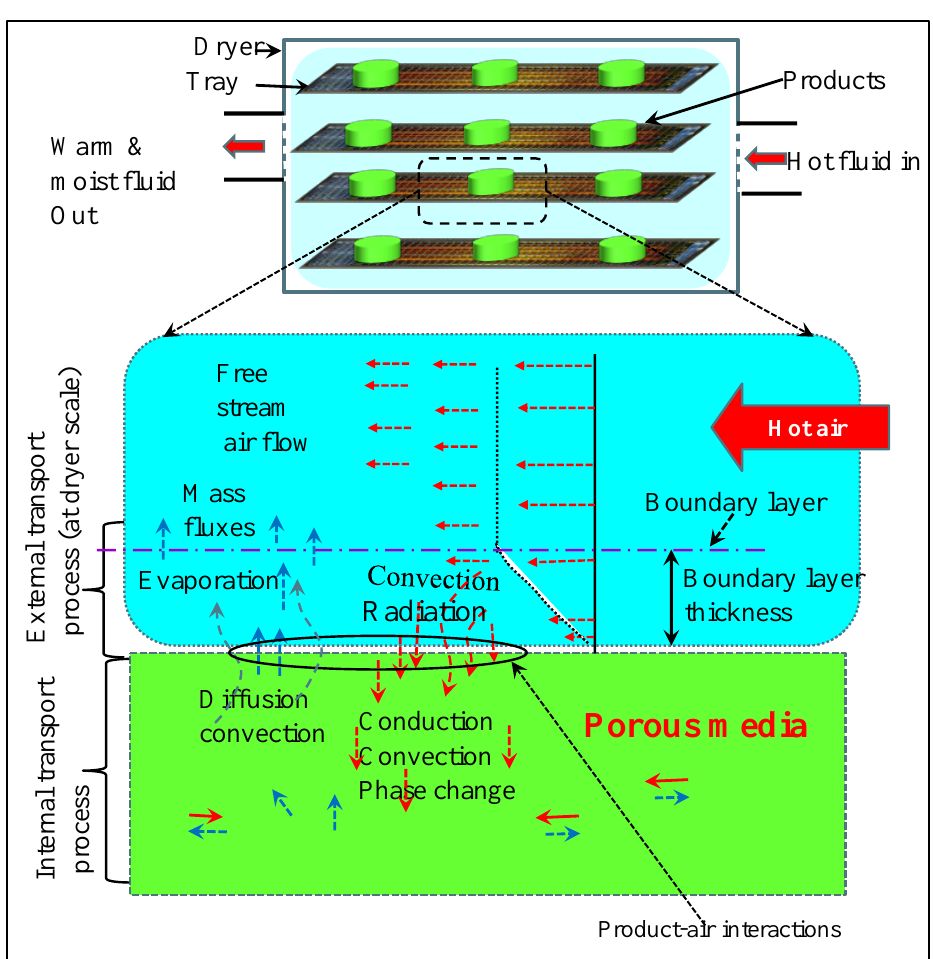
Figure 1. Schematic representation of convection air drying processes.